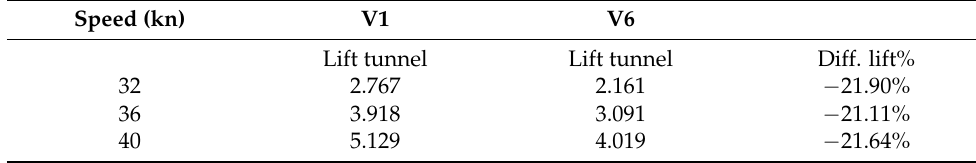
Table 8. Lift computed on tunnel surface.